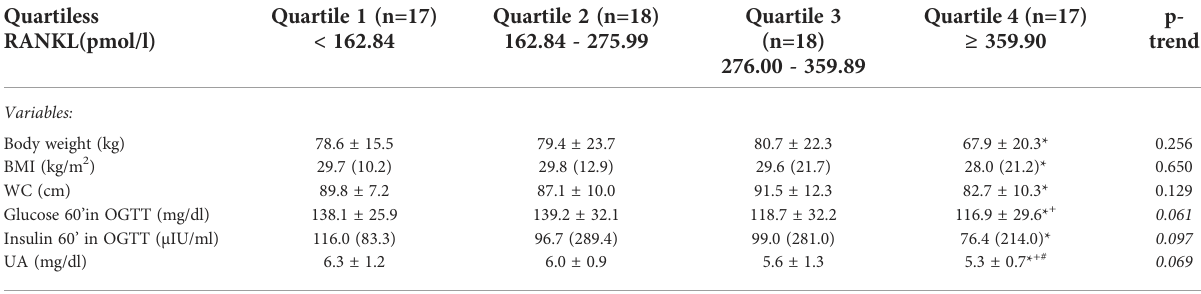
TABLE 2 Characteristics of chosen anthropometric and biochemical parameters after strati fi cation according to the sRANKL quartiles in the study group. Quartiless RANKL(pmol/l)